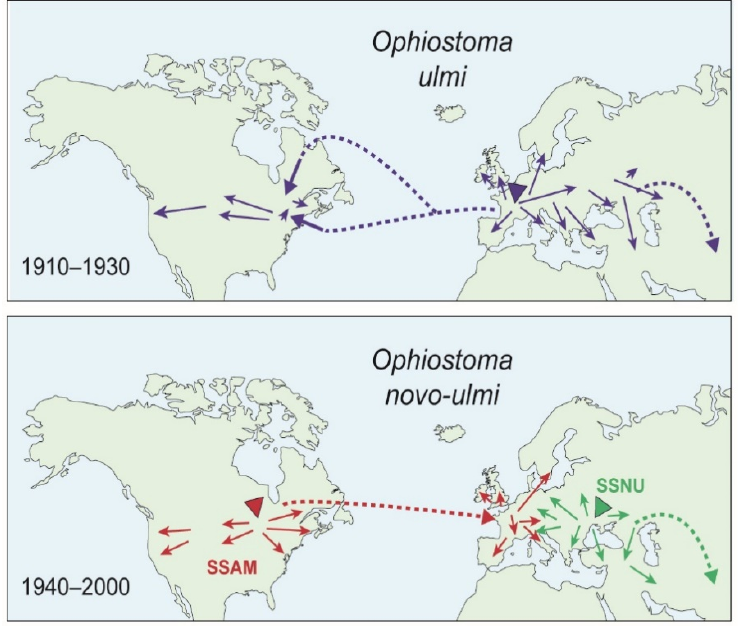
Figure 1. Introduction and spread of Ophiostoma ulmi and the O. novo-ulmi subspecies. Large arrowheads, primary introduction events. Small arrows, subsequent migrations. Dashed arrows, secondary importation events. Above, spread of O. ulmi (blue) ca. 1910–1940. Below, spread of O. novo-ulmi subsp. americana (SSAM, red) and subsp. novo-ulmi (SSNU, green) ca. 1940–2000. Note: (1), O. novo-ulmi spread into the areas previously occupied by O. ulmi . (2), SSAM spread from North America to western Europe in ca. 1960s. (3), SSAM and SSNU began to overlap in western Europe from ca. 1970s. Adapted from [16]. Based on characterisation of >6500 samples from the authors’ surveys [24].